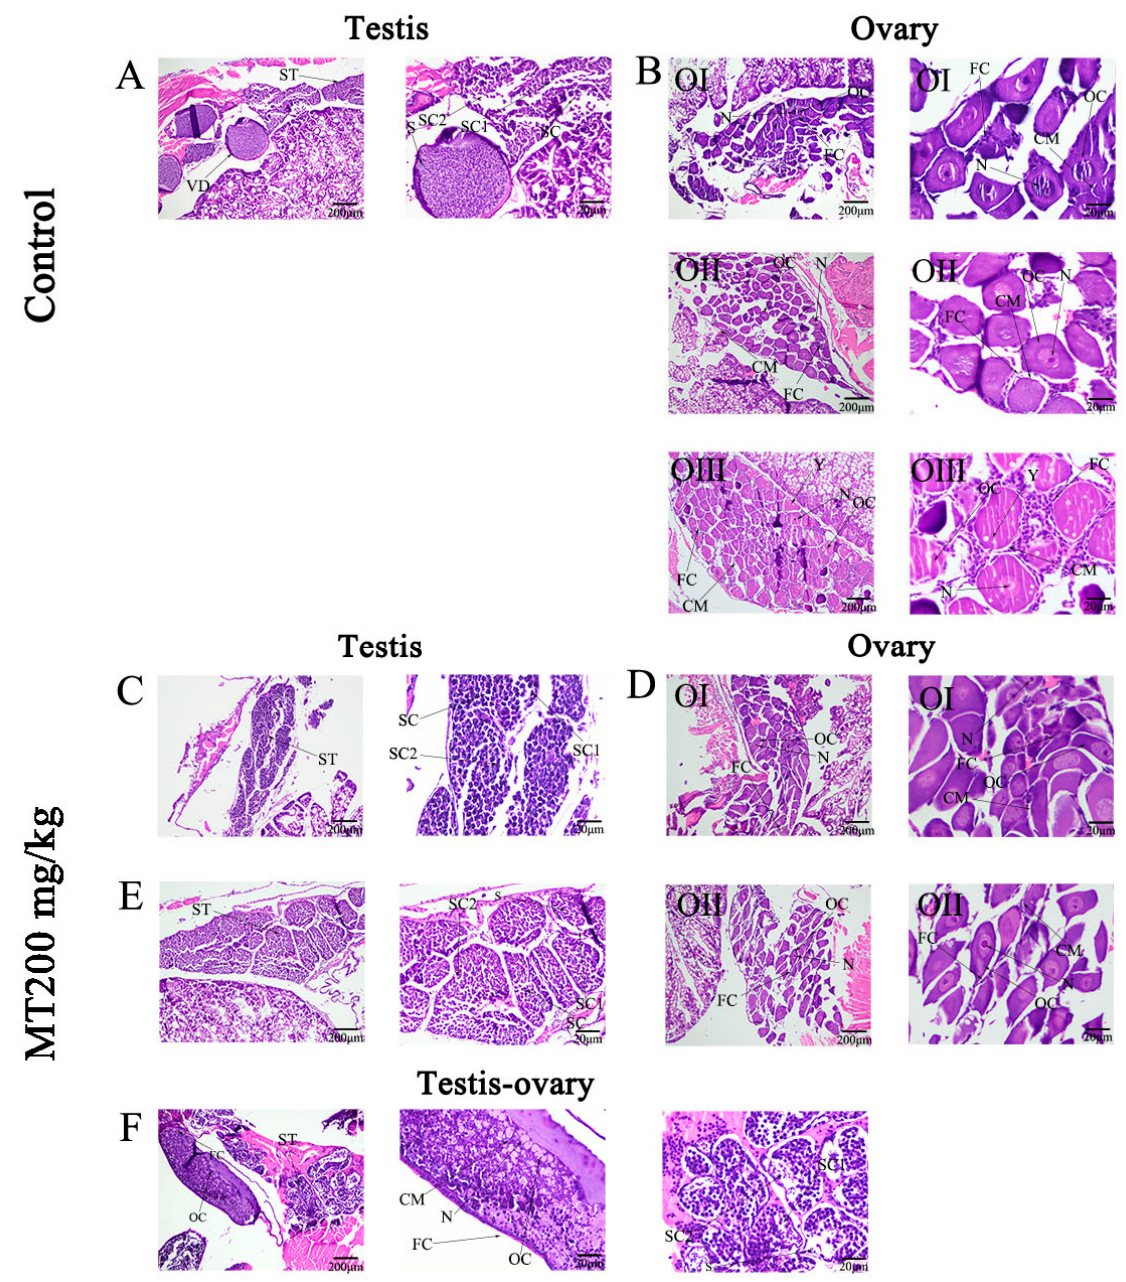
Figure 3. Histological sections of ( A ) male prawn testis in the control, ( B ) oocyte Ⅰ , oocyte II and oocyte III of female prawns in the control, ( C , E ) testis of male prawns in the 200 mg/kg MT group, ( D ) oocyte I and oocyte II of female prawns in the 200 mg/kg MT group, and ( F ) testis–ovary of male prawns in the 200 mg/kg MT group. N: nucleus; ST: spermatid; SC: spermatocyte; SC1: primary spermatocyte; SC2: second spermatocyte; S: sperm; VD: vas deferens; OC: ovarian cavity; FC: follicle cells; CM: cytoplasmic membrane; Y: yolk granule. Scale bars: 200 µm and 20 µm.